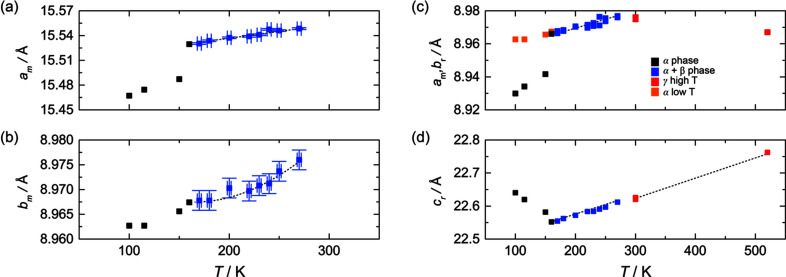
Evolution of the unit-cell parameters of Ag3Sc2(PO4)3 with changes in tem­per­ature.